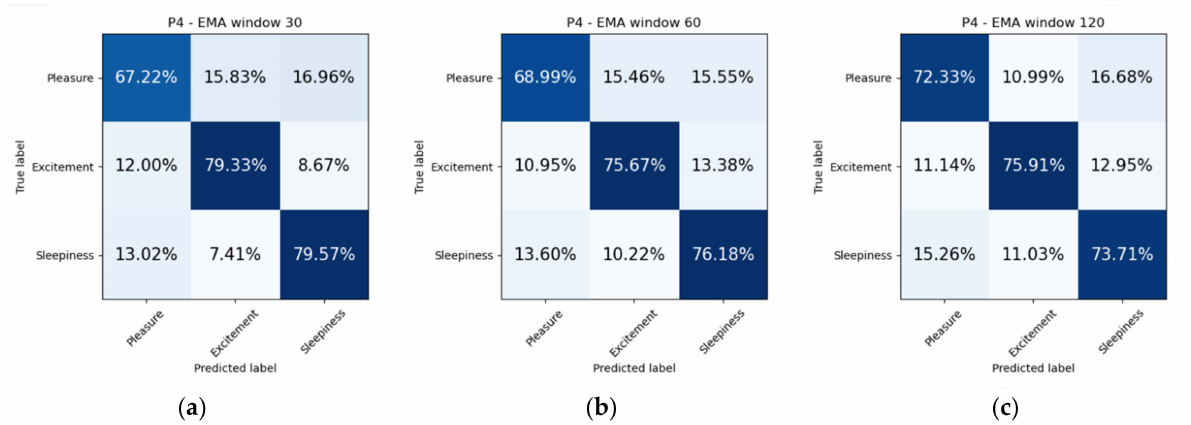
Figure 15. Confusion matrix for patient P4 for windows ( a ) 30-, ( b ) 60-, ( c ) 120-min. Predicted mood states: Pleasure, Excitement and